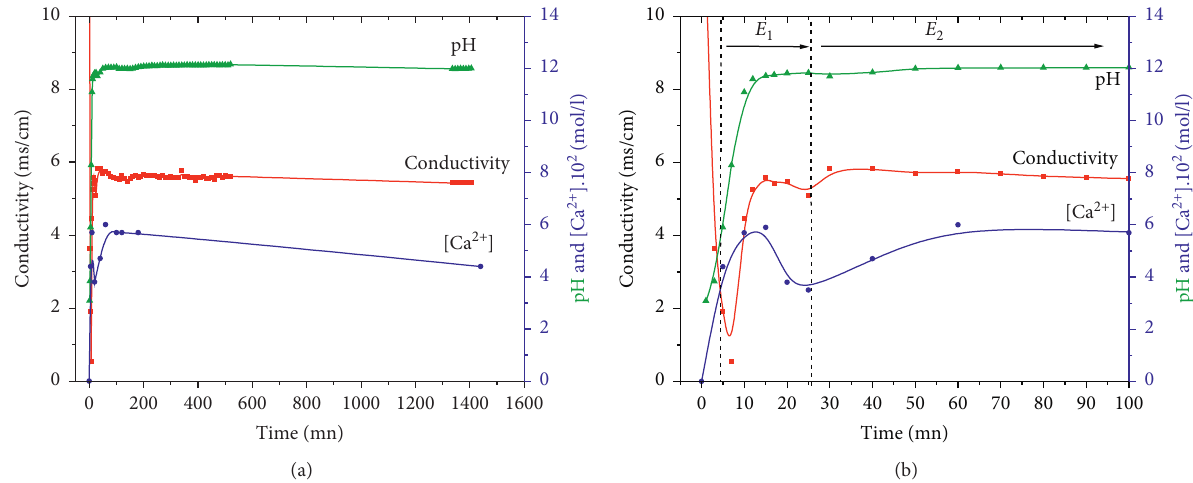
Figure 2: (a) Evolution of the conductivity, pH, and Ca 2+ concentration for mixture M 1. (b) Evolution of the conductivity, pH, and Ca 2+ concentration relative to mixture M 1 during the first 100